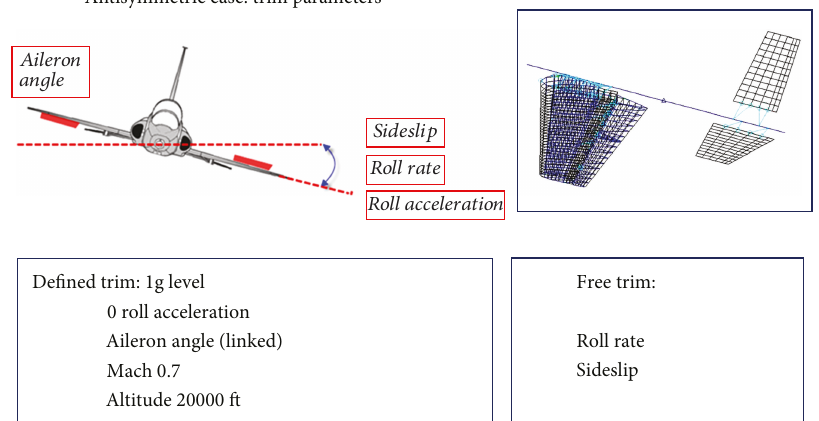
Figure 1: Antisymmetric trim for ailerons.